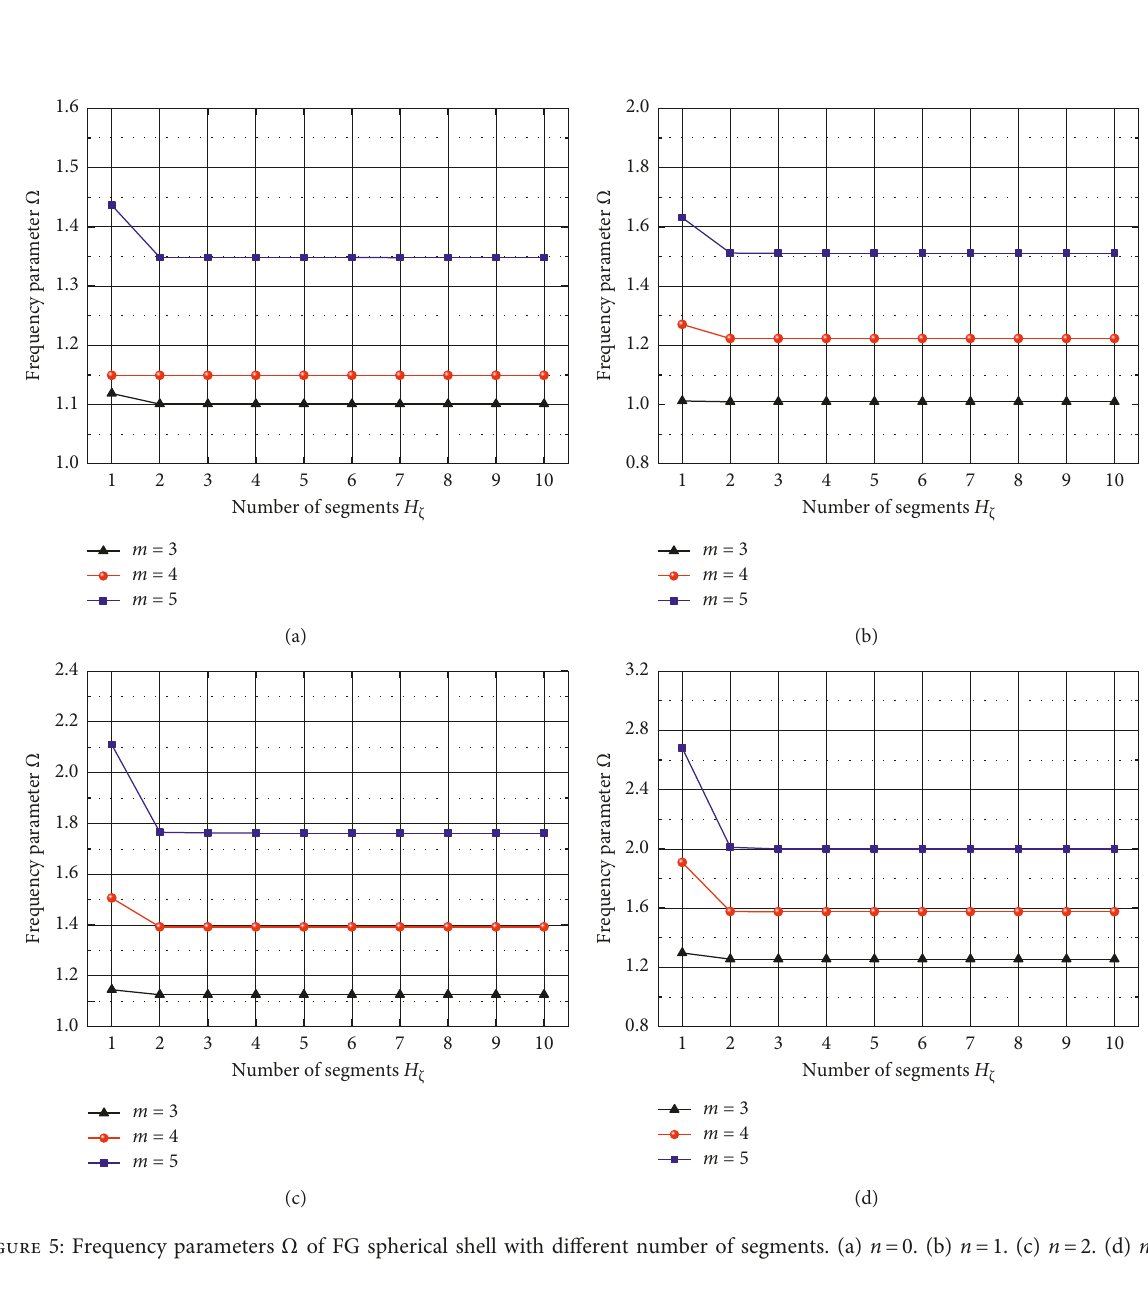
of FG spherical shell with different number of segments. (a) n Ω